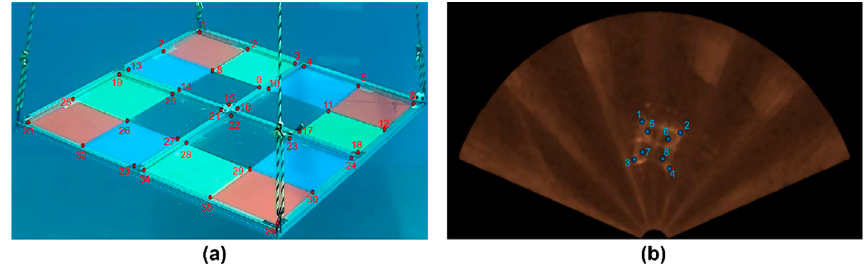
Figure 8. Corner detection numbering, ( a ) thirty-six optical and ( b ) eight sonar corner image points for estimating coordinate transformation matrices .